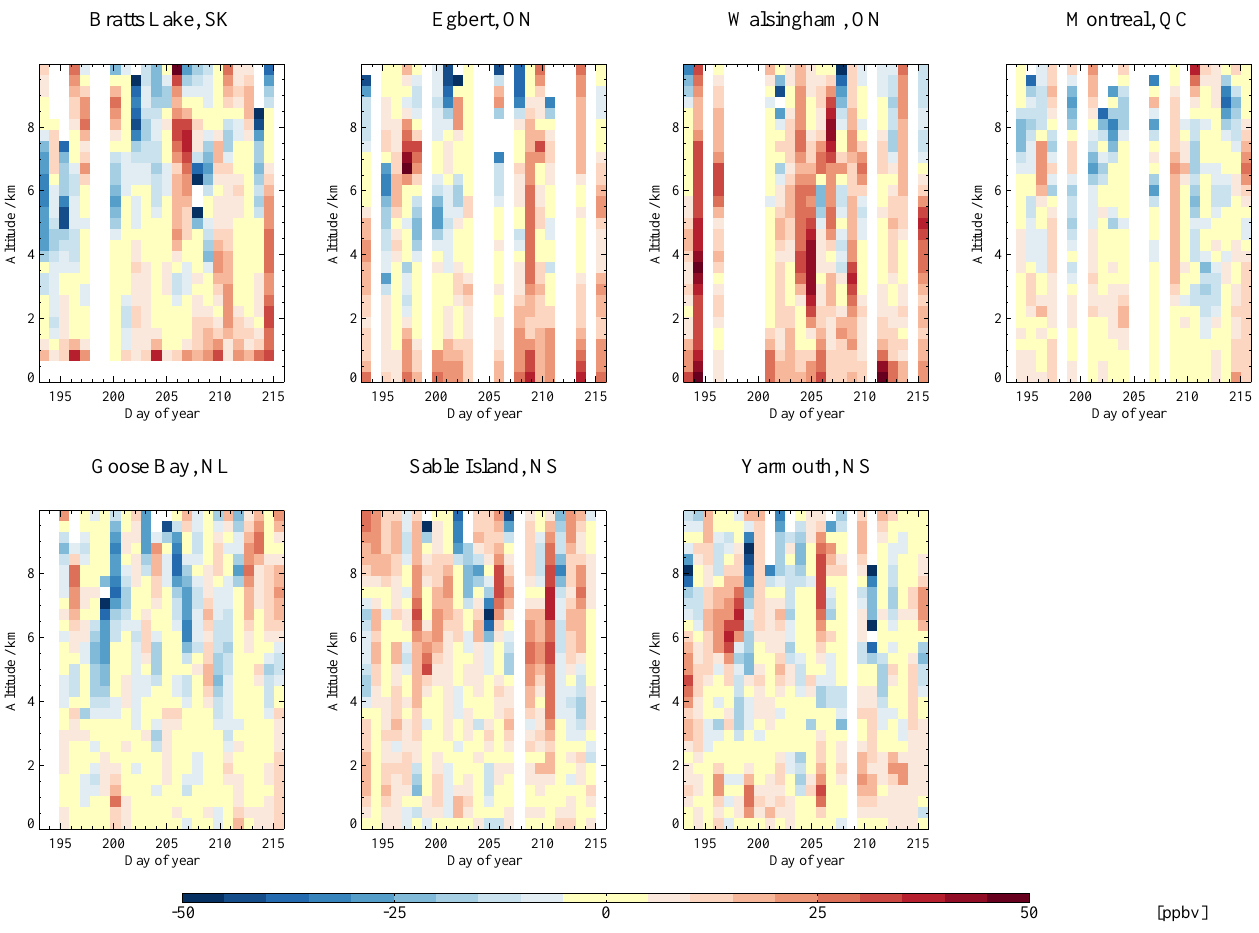
Fig. 4. Time-height cross-sections of the daily ozone differences between GEOS-Chem and ozonesonde profiles over each of the ozonesonde launch sites (Table 1) during the BORTAS-A measurement campaign (12 July to 4 August 2010). White indicates no data